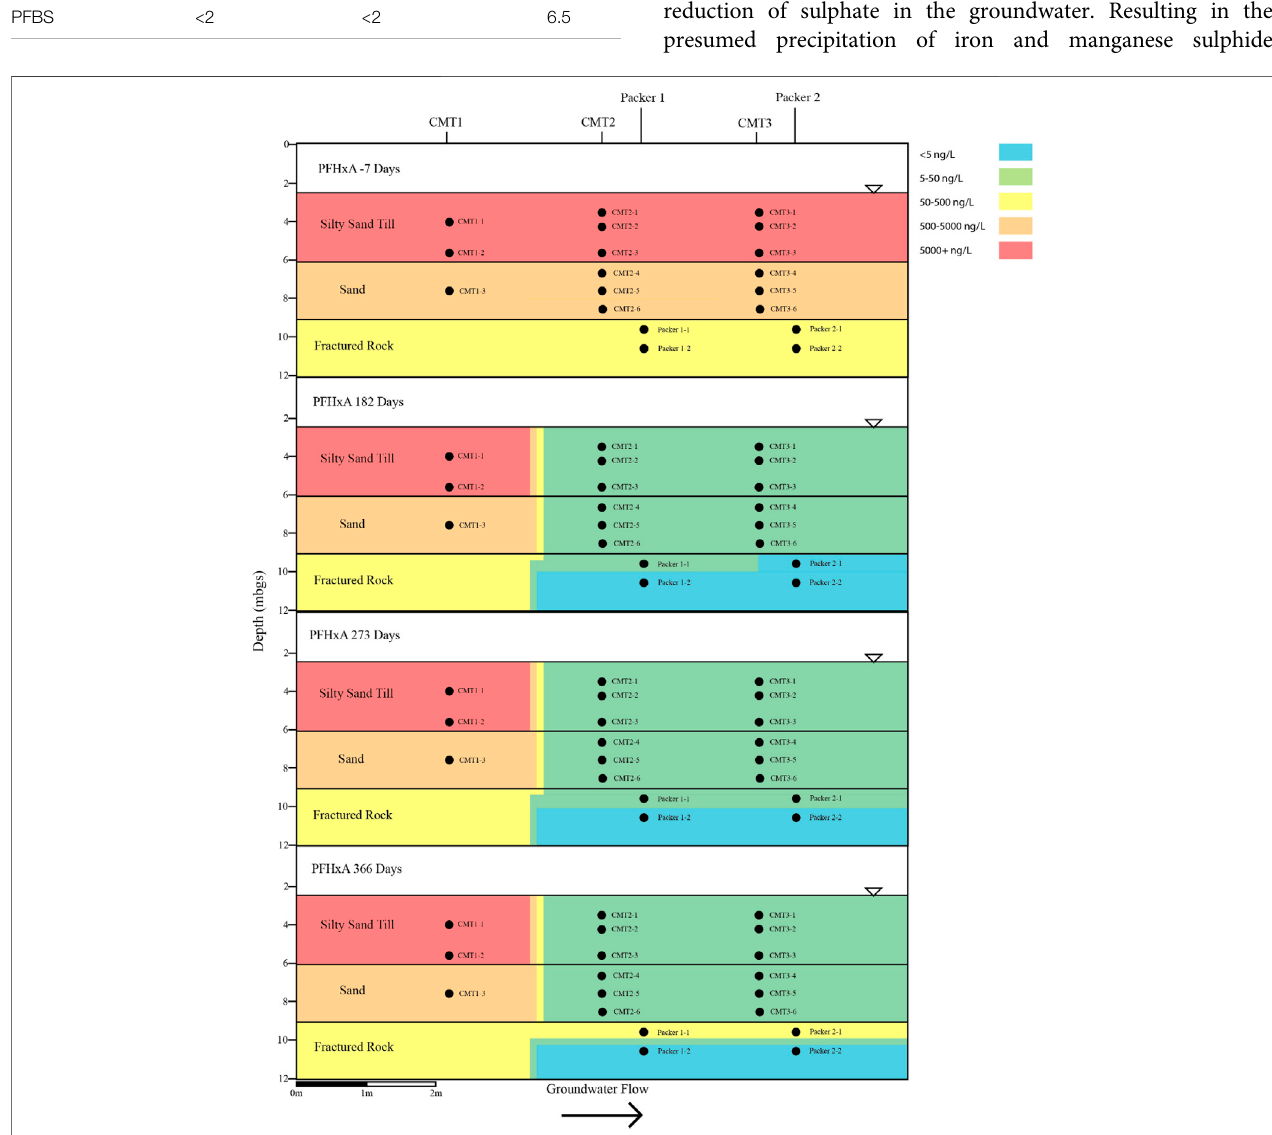
FIGURE 4 | Cross sectional view of PFHxA within groundwater determined pre- and post-injection of the CAC within the three aquifers.